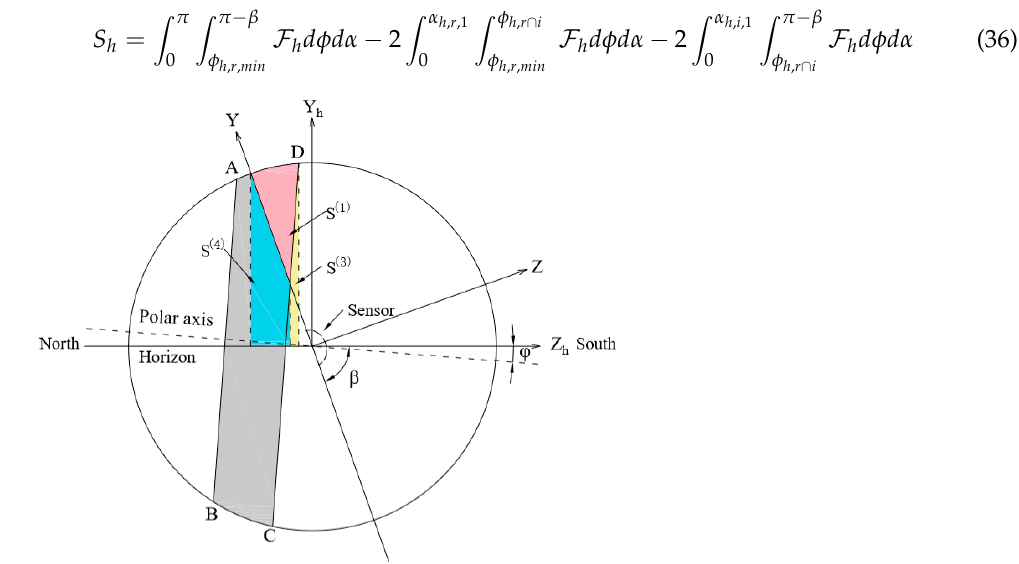
Figure 13. Schematic diagram for the calculation of S h while d r ≤ 0 and φ h , l , min > π − β > φ h , r , min . (9) while d r ≤ 0, φ h , r , min > π − β , shown as Figure 14, it is easily understood that the Equation (5)